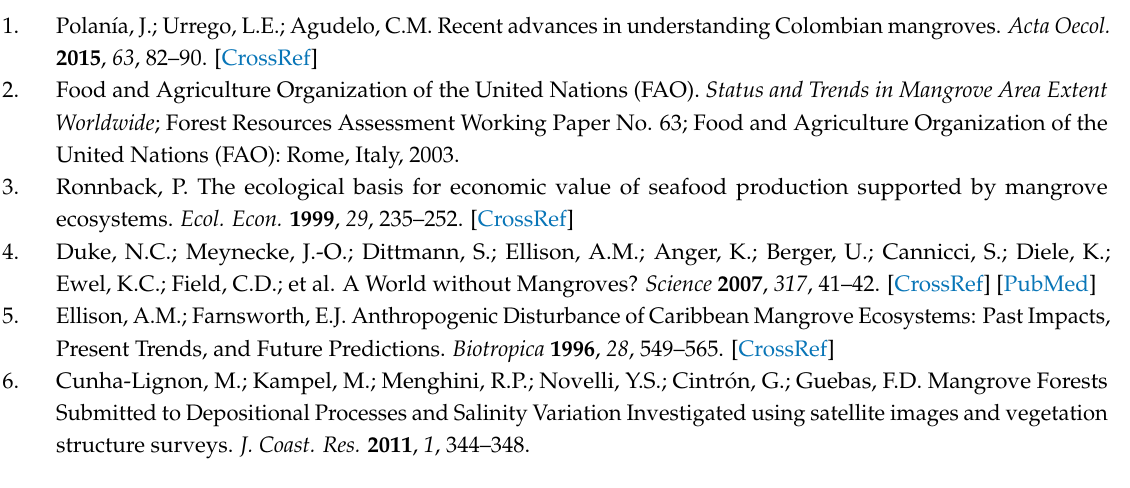
Table S1: Summary of floral and faunal diversity indices of three sites; Table S2: Fauna observed in the three study sites; Table S3: Occupation diversity in the three study sites; Table S4: Mangrove species in Sri Lanka. Acknowledgments: We thank Yirga Alemu, Dinesh Jayasundara, Supun Wellappuliarachchi, Dayani Shermila for their assistance with field work and Fiona R. Worthy for English language editing of the manuscript. This study was funded by the Chinese Academy of Sciences’ Frontier Science Key Project (grant number